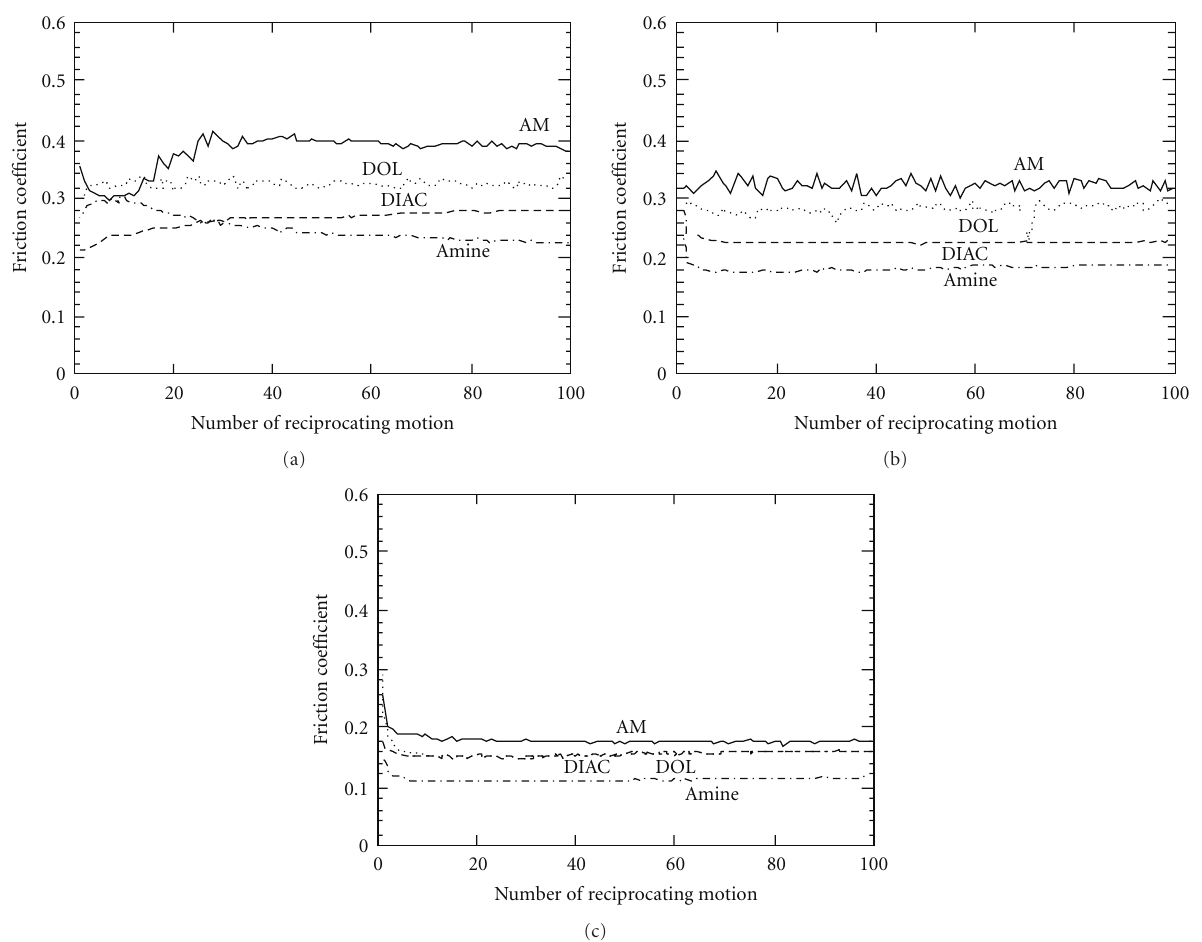
Figure 20: Frictional properties of each PFPE based on the di ff erent surface roughness using (a) 8nm, (b) 12 nm, and (c) 18 nm particles.